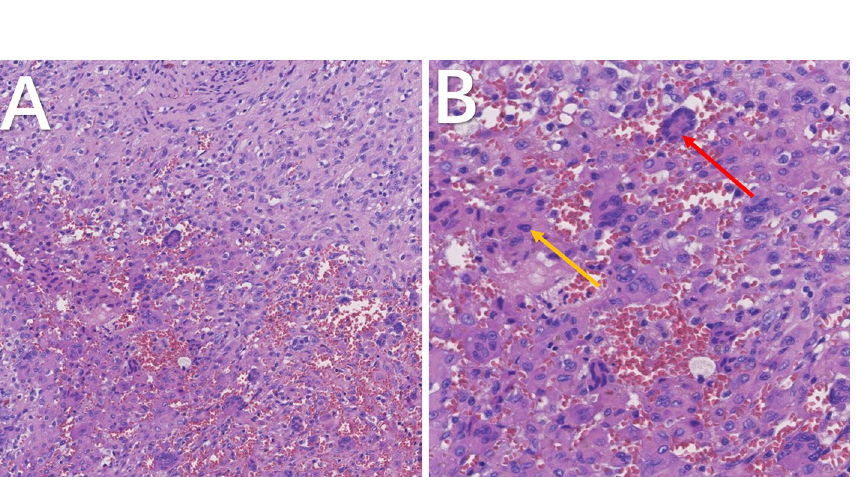
Figure 2. Representative histology from patient 9. The lesion composed of plenty of multinucleated giant cells (red arrow) and mononuclear cells (yellow arrow) with hematoxylin–eosin stain ( A and B